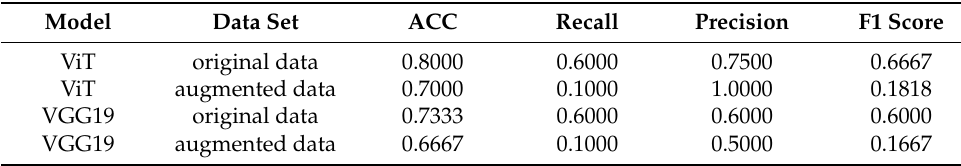
Table 4. Binary classification performance of ViT and VGG19.